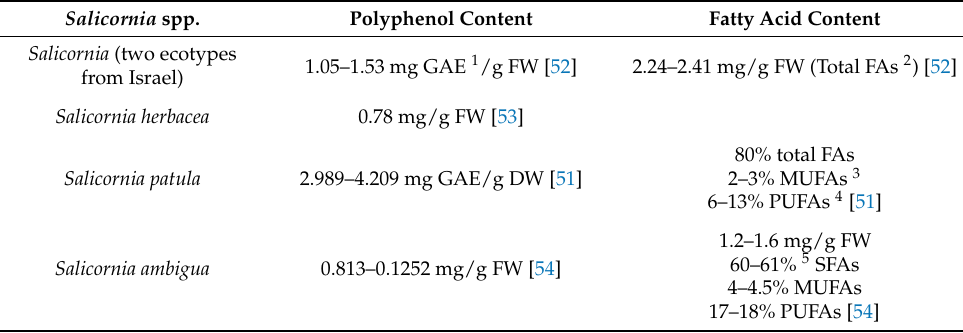
Table 3. Some examples of polyphenol and fatty acid content in Salicornia